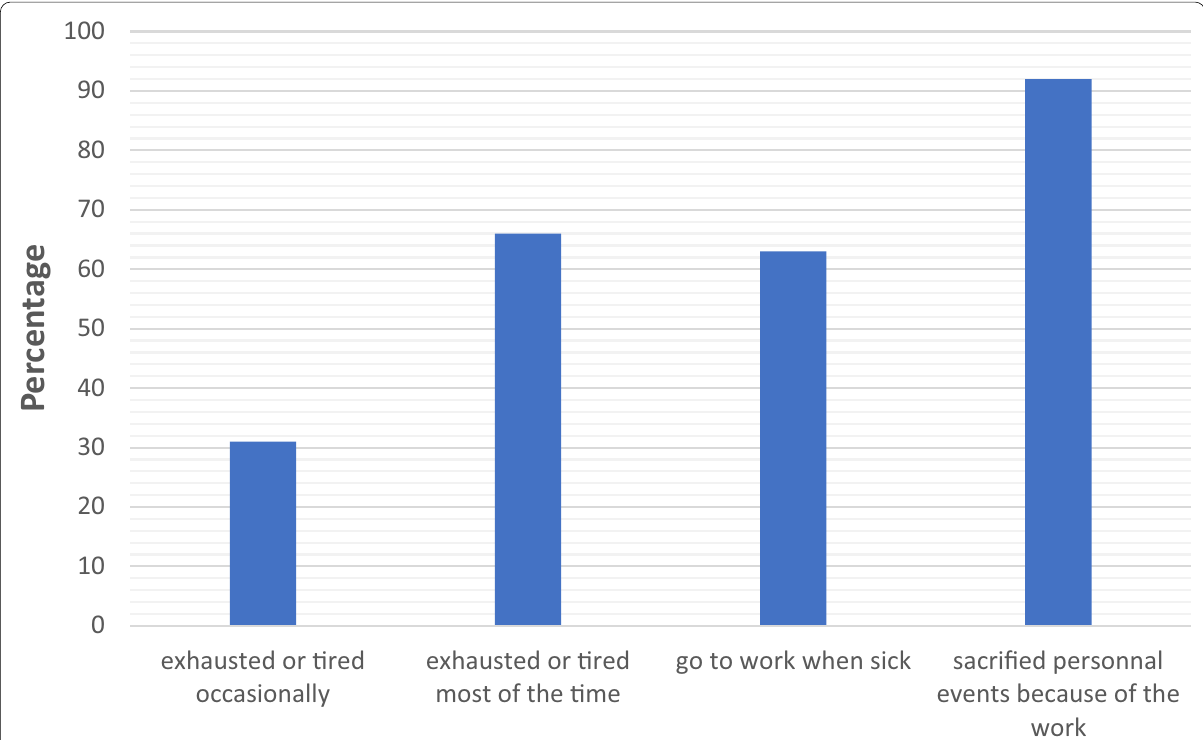
Fig. 3 Represents the distribution of the respondents as a function of their perceived fatigue and in function of being sick or not ( N